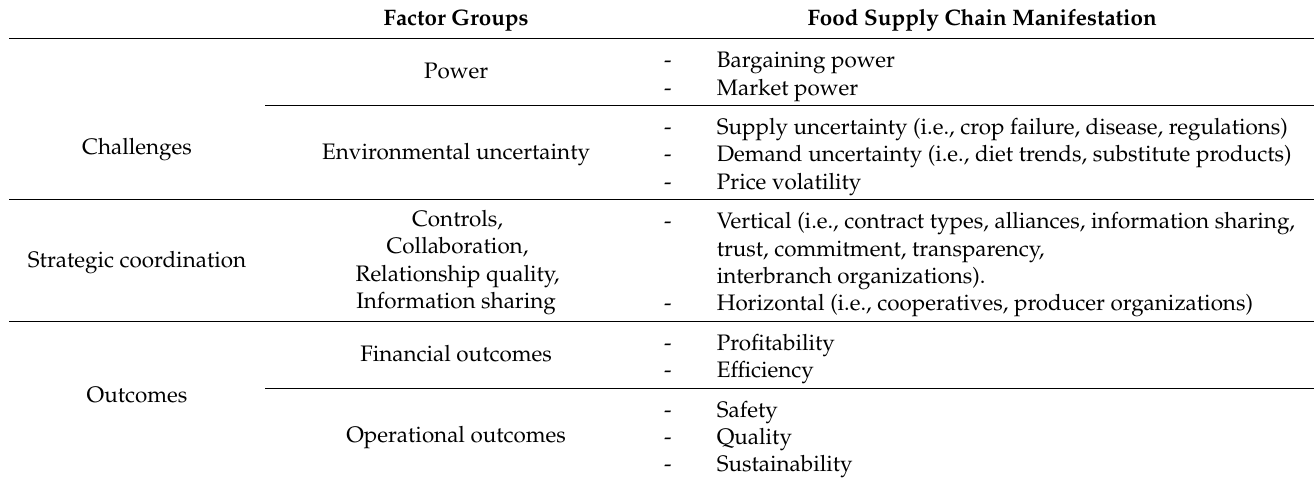
Table 2. Manifestations of the immediate factors leading to and resulting from IOF in food